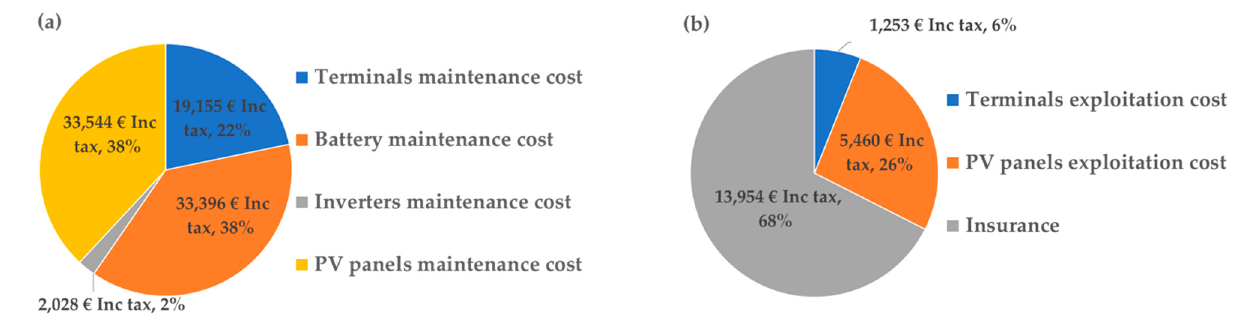
Figure 3. ( a ) Maintenance cost, ( b ) exploitation cost.